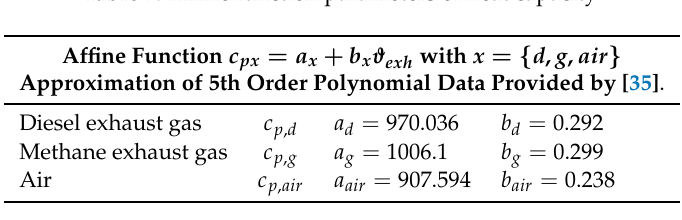
Table 7. Affine function parameters of heat capacity.